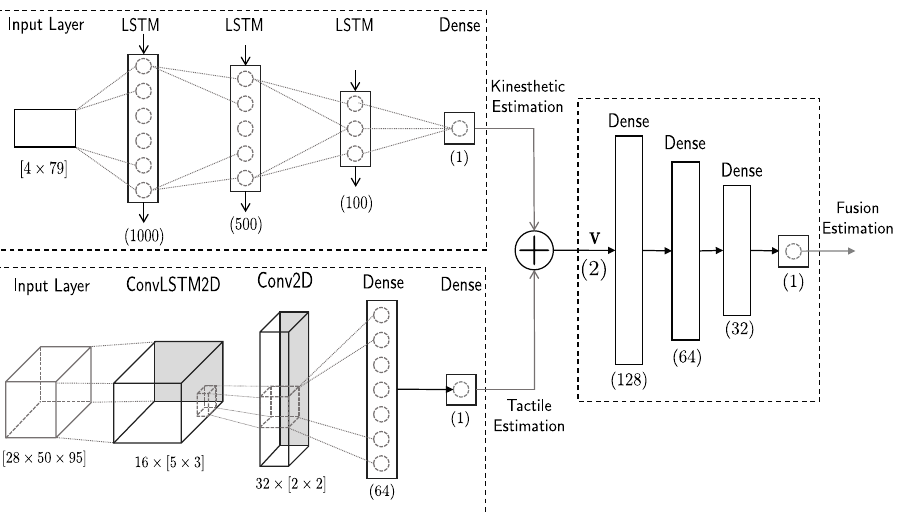
Figure 6. Diagram of the regression neural network structure. Kinesthetic and tactile data are trained separately. The kinesthetic network is defined by three LSTM layers and a fully connected layer. The tactile network is formed by a convolutional LSTM layer with a convolutional layer and two fully connected layers. Both outputs are concatenated and fed to a fully connected layer fusion network that uses both sources of information to improve the